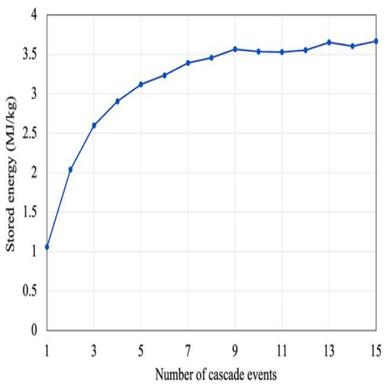
Accumulation of stored energy in graphite with increased number of cascade events simulated at 150 ◦C.